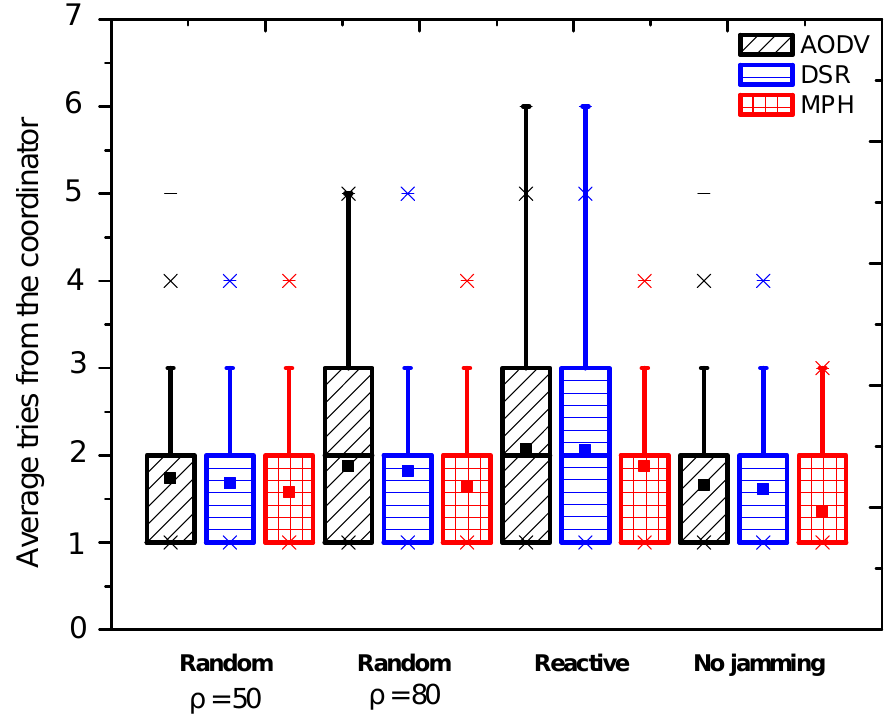
Figure 6. Average tries when the jammer node is in the middle of the